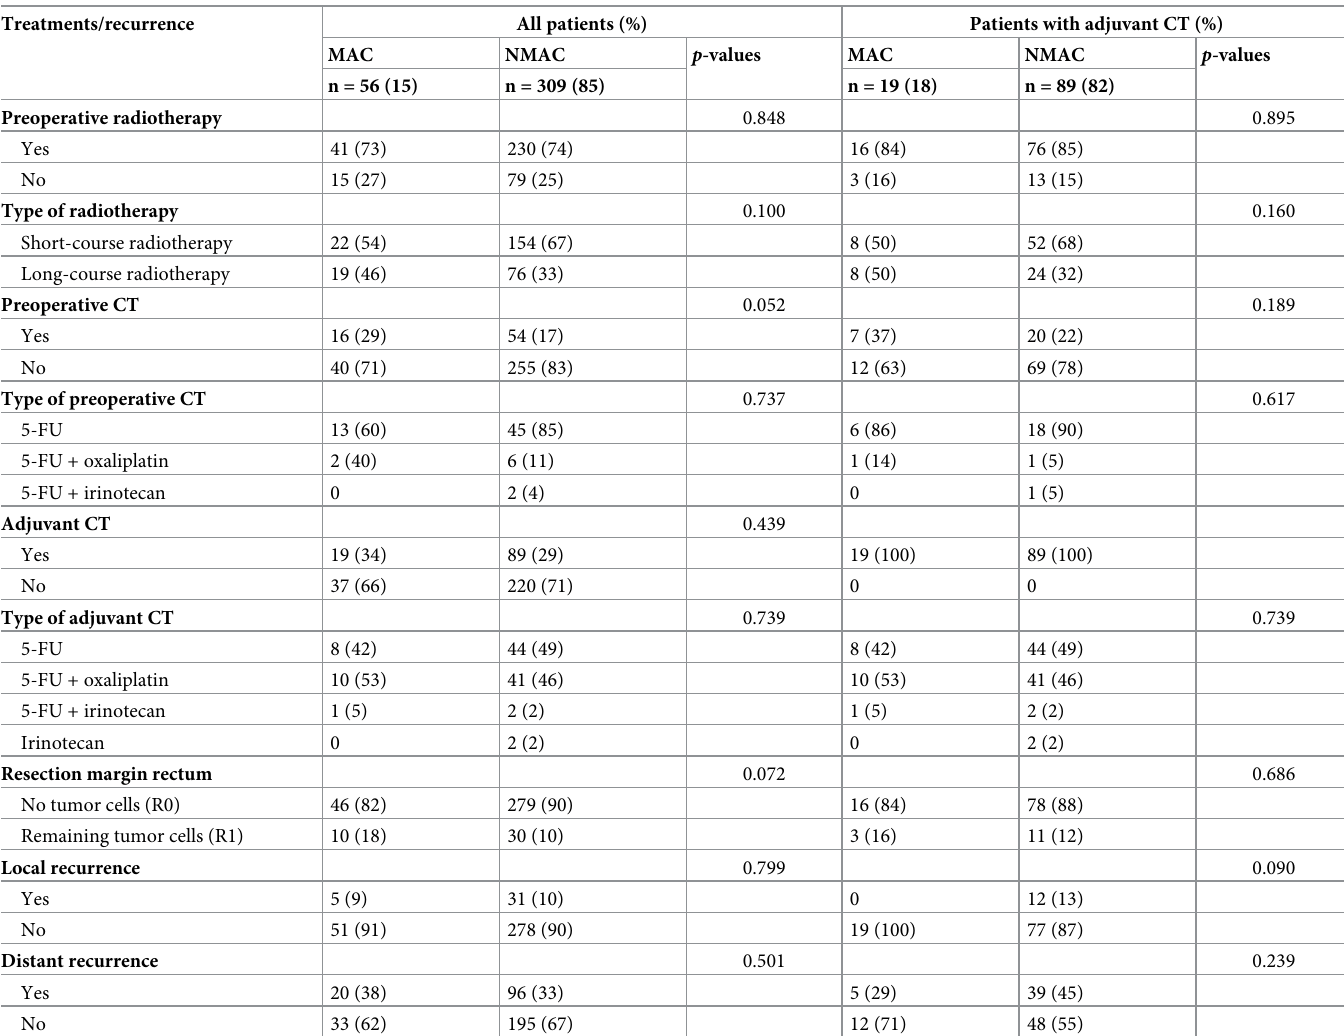
Table 2. Oncological treatment and recurrence in rectal cancer